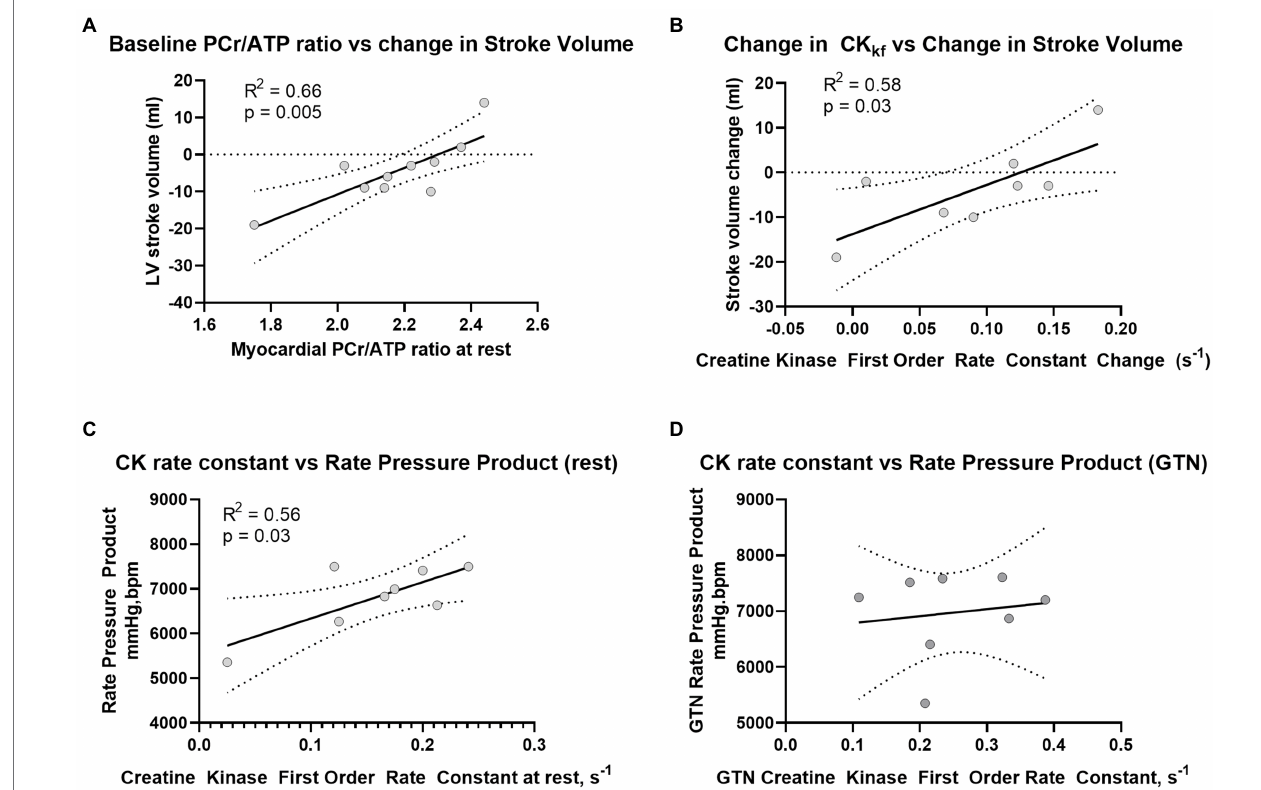
FIGURE 4 | Relationship between (A) PCr/ATP and LV Stroke volume at rest, (B) change in CK rate constant and change in LV stroke volume during GTN, (C) Rate Pressure Product at rest and CK rate constant before, and (D) during GTN